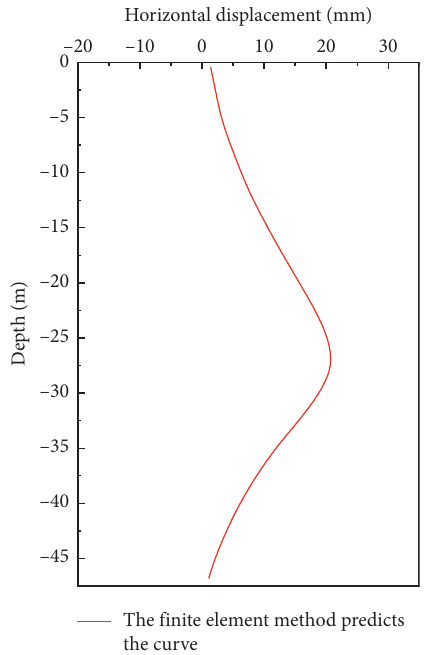
Figure 14: Prediction of the horizontal deformation of the continuous wall.